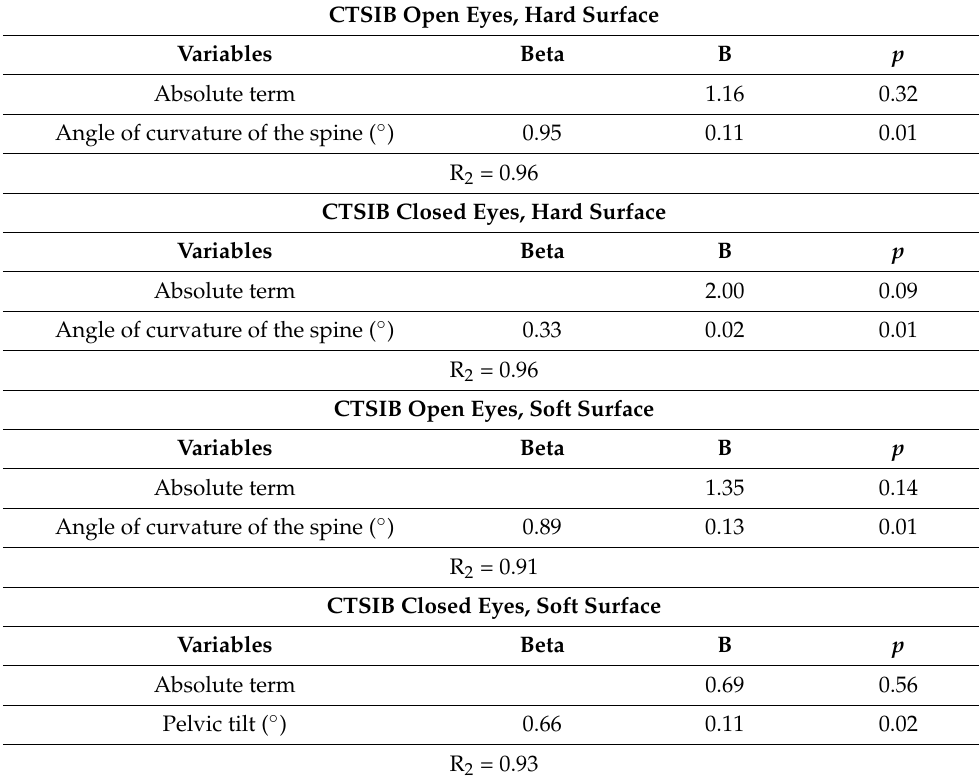
Table 3. Regression analysis for the Clinical Test of Sensory Integration and Balance in post-tests: open and closed eyes, hard surface, and open and closed eyes, soft